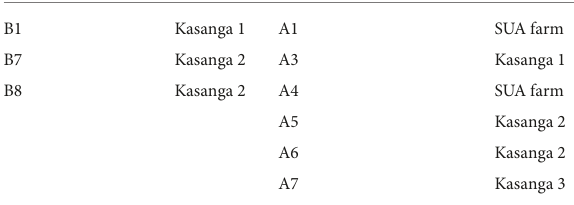
TABLE 7 Microbial isolates that their DNA could not be sequenced. Bacterial isolate Location Actinomycete isolate